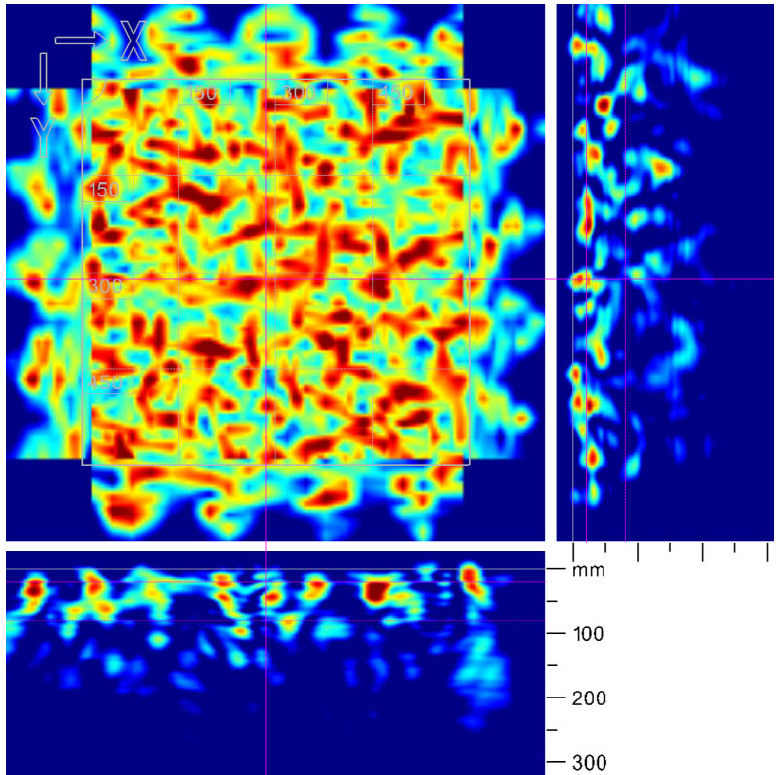
Figure 6. Two-dimensional visualisation of data obtained by the radar-based technique.